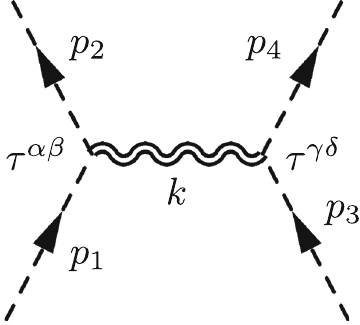
Fig. 2 The scattering of two massive scalars by the exchange of a graviton in the t -channel. The particles have mass m 1 and m 2 , and the off-shell momentum k = p 1 − p 2 = k 4 − k